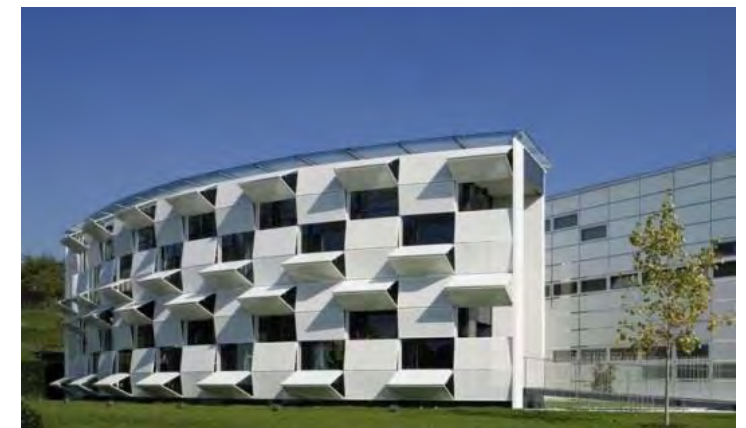
Figure 5. The dynamic solar shading of Kiefer Technic Showroom